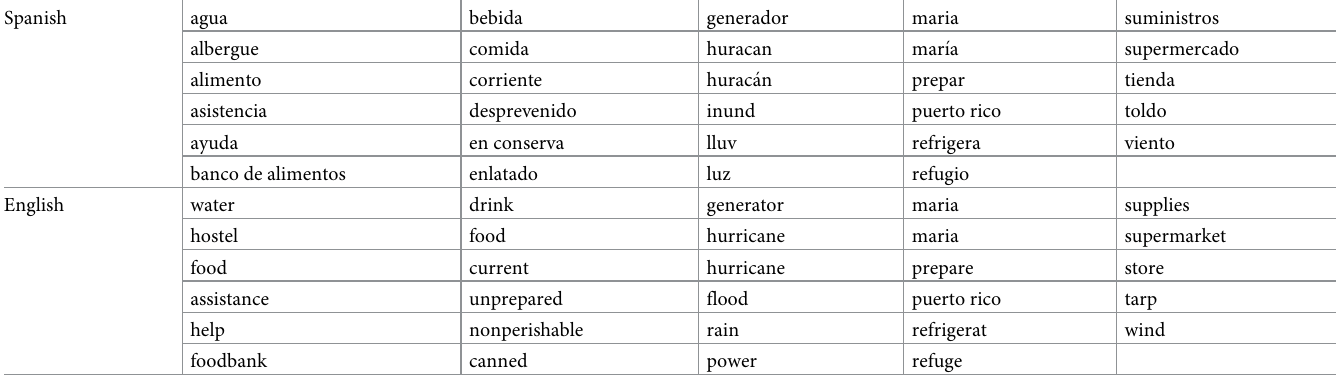
Table 1. Words used to flag tweets in our study (top) and their English translations (bottom).